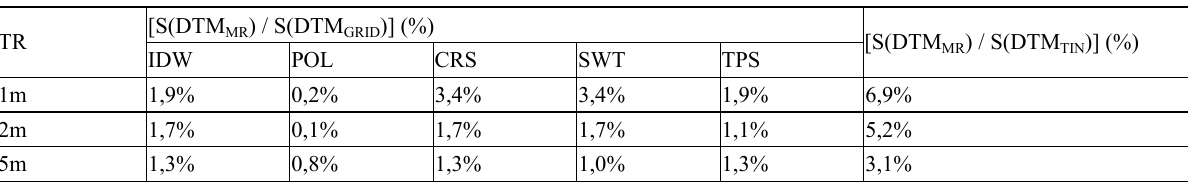
Table 7. Storage size comparisons between DTM MR and DTM GRID , DTM